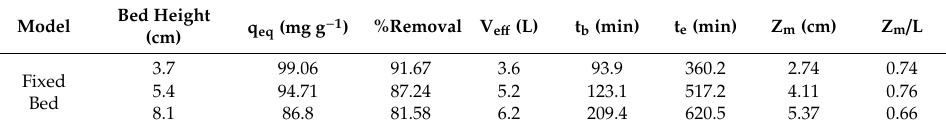
Estimated operational variables from fixed bed studies for CV adsorption on